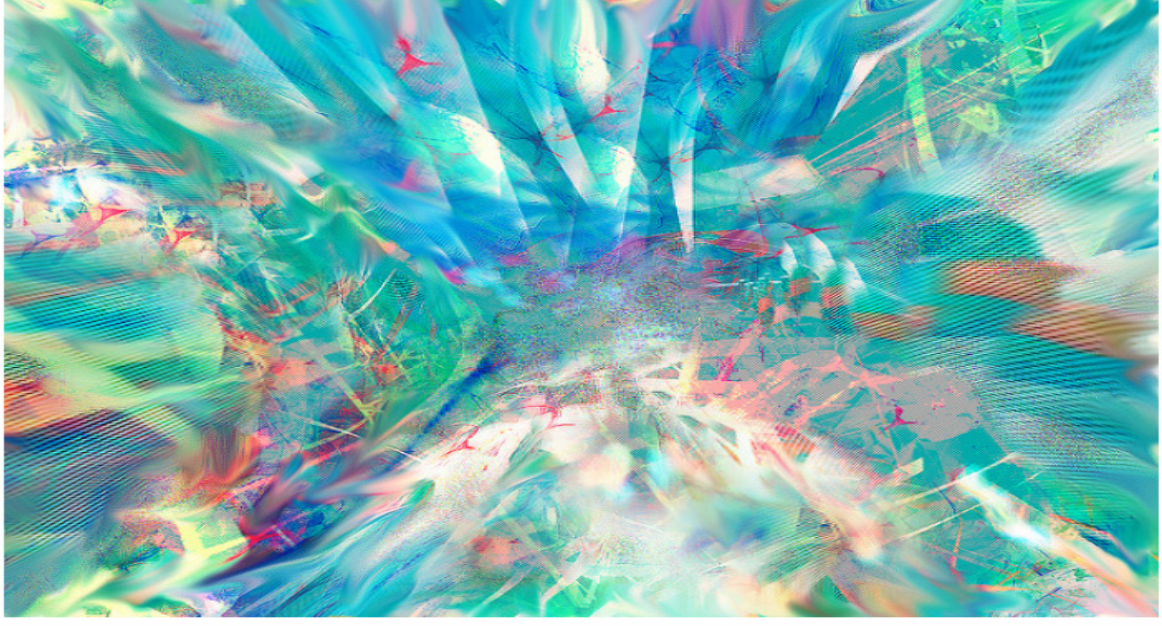
Figure 3. Abstract Art [45]. Photo Credit: Tom Tennstedt.